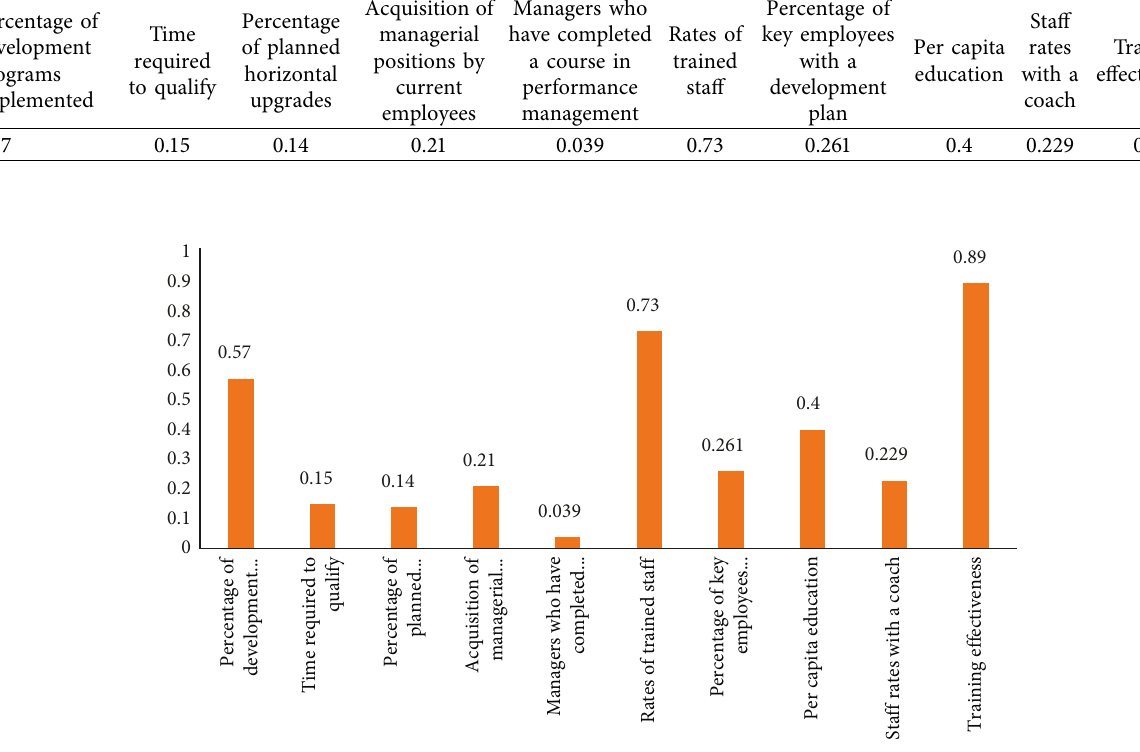
Figure 5: Weight of criteria in terms of growth and